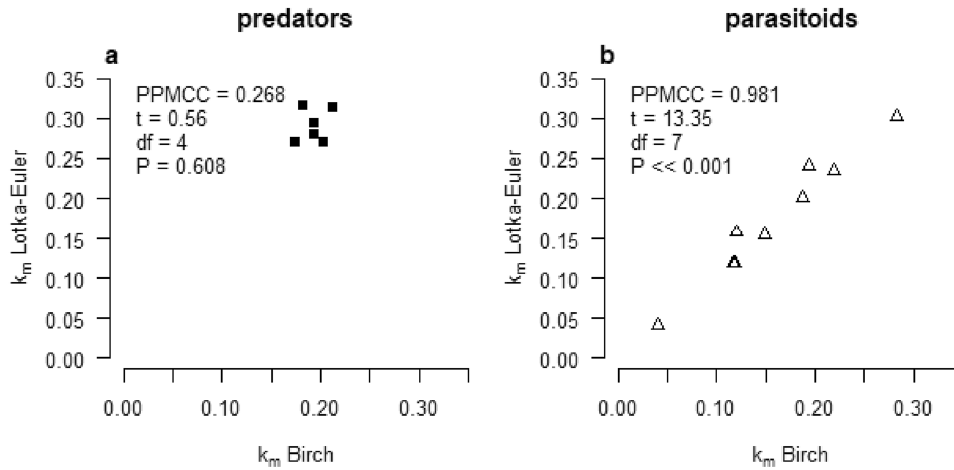
Figure 2. Correlation between values of k m calculated by the Birch (x-axis) and the Lotka-Euler (y-axis) approach for predators ( a ) and parasitoids ( b